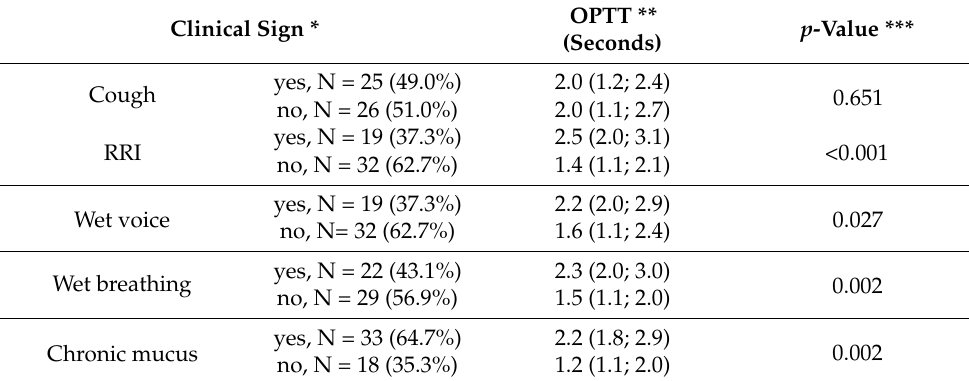
Table 6. Relationship between clinical signs and oropharyngeal transit time (OPTT).